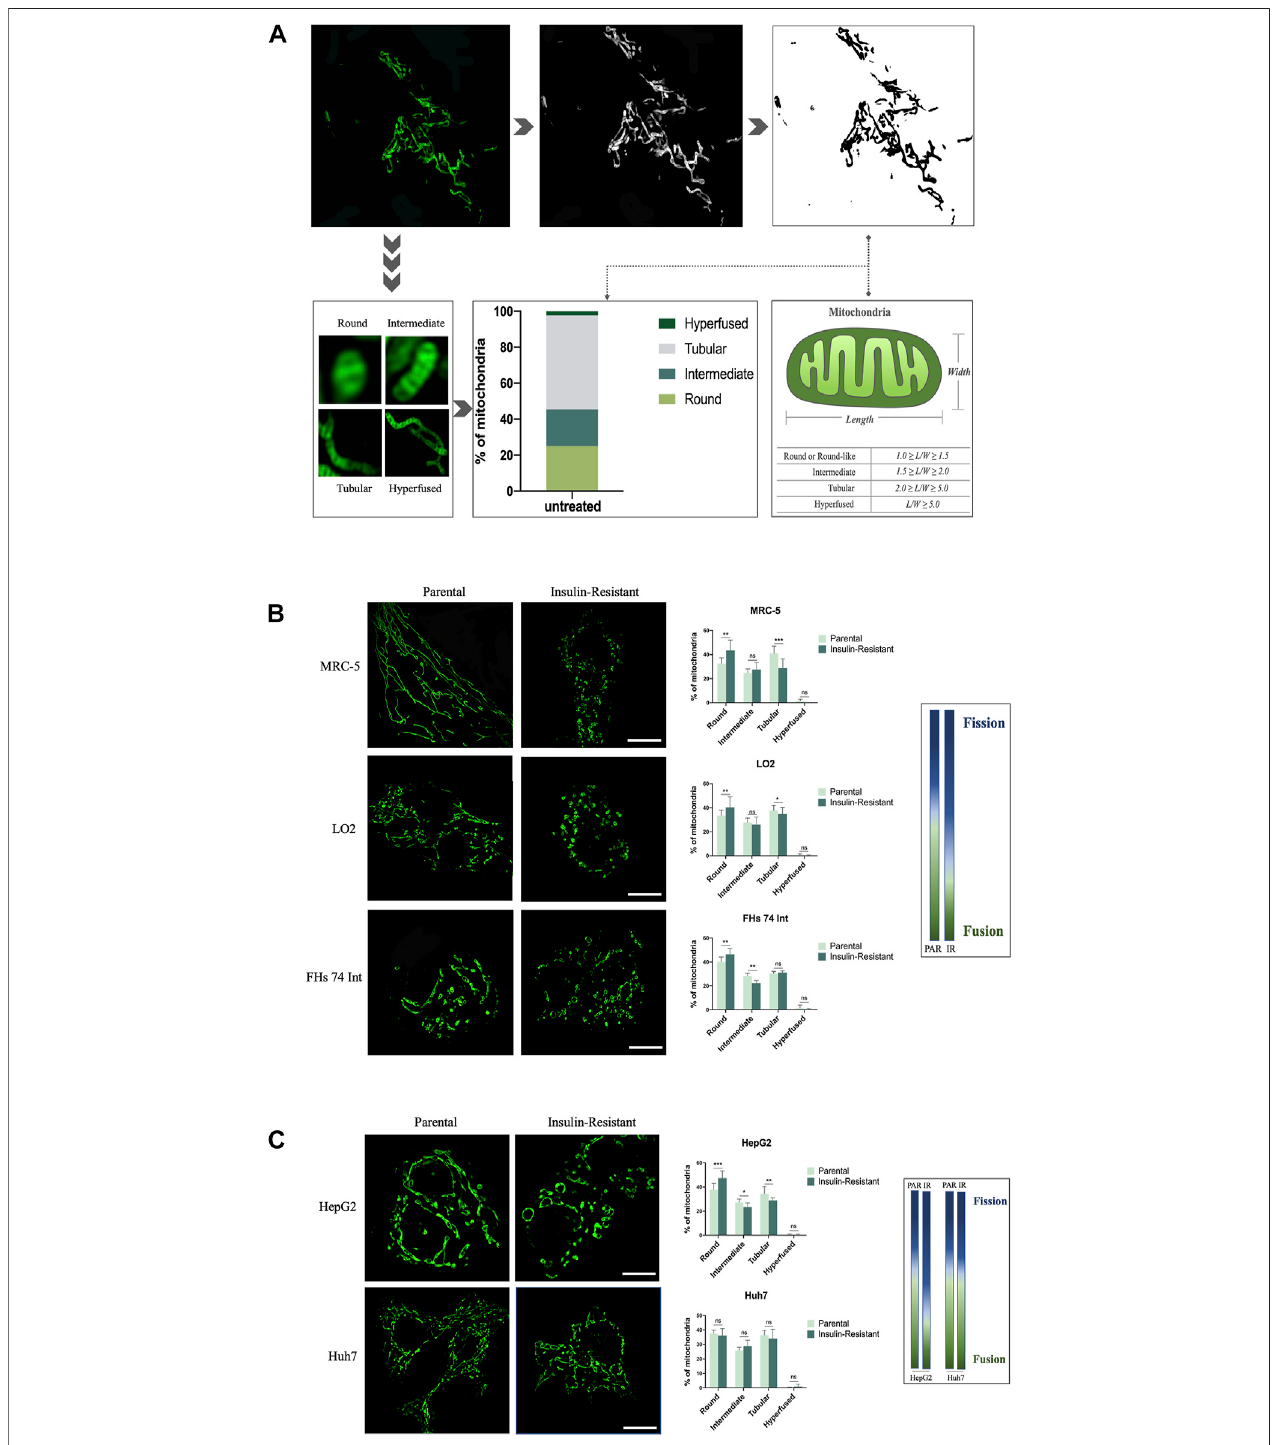
FIGURE 1 | SIM-based imaging of mitochondrial morphology for quantitative analysis in IR cells. (A) After being captured by SIM, the image of mitochondria in a 786-O cancer cell was transformed to an 8-bit format, and the length/width of the mitochondria was further analyzed by ImageJ software. (B) Representative images of mitochondrial morphology and corresponding quantitative analysis for the four morphological groups (round, intermediate, tubular, and hyper-fused) in parental and IR MRC-5, LO2, and FHs 74 Int cells, respectively. (C) Representative images of mitochondrial morphology and corresponding quantitative analysis for the four morphological groups (round, intermediate, tubular, and hyperfused) in parental and IR HepG2 and Huh7 cancer cells, respectively. Scale bar: 10 μ m. Data showed as mean ± SD. * p < 0.05, ** p < 0.01, and *** p < 0.001, ns: no signi fi cance. The gradient column chart indicates the trend of morphological changes, referring to the fi ssion and fusion of the